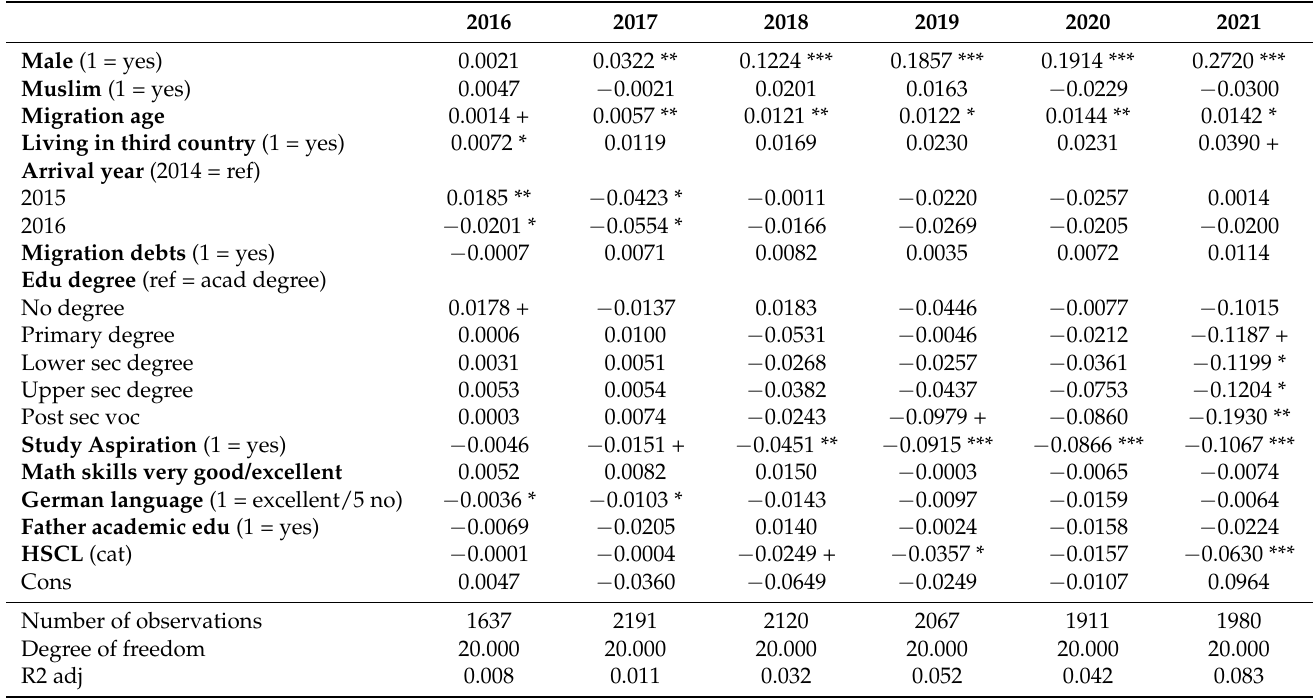
Table A2. Effects of mental disorder screening diagnosis (HSCL, anxiety, and depression) in 2016 on being full-time employed—2016–2021—OLS